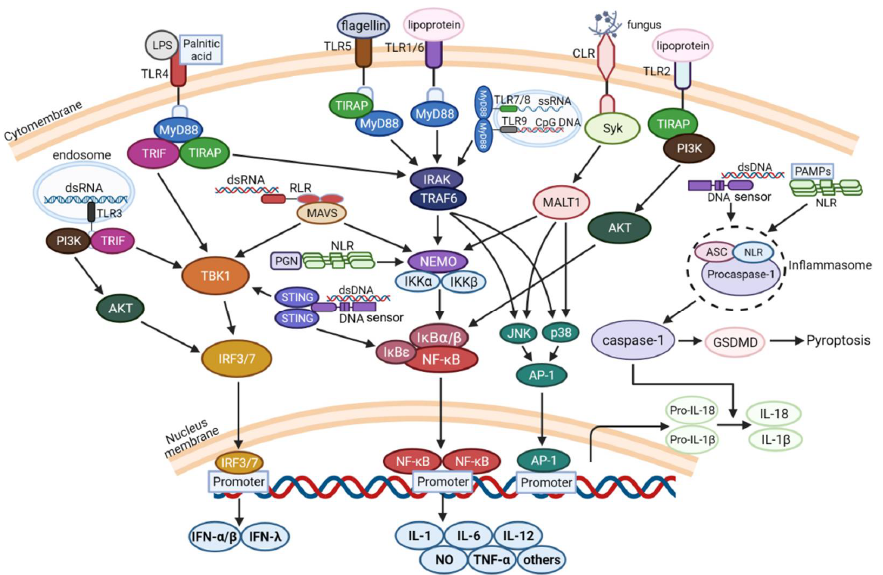
Figure 2. Schematic diagram of signaling transduction pathways in host response induced by recog- nition of PAMPs by PRRs. Sensing PAMPs, the PRRs recruit and activate MyD88, TRIF, TIRAP, and other adapters. These adapters transduce activating signals, which finally induce activation of transcriptional regulators NF- κ B and IRFs, leading to the expression of IFNs and proinflam- matory cytokines or mediators, such as IL-1, IL-6, IL-12, TNF- α , NO, etc. Abbreviation: MyD88, myeloid differentiation factor 88; TRIF, TIR domain-containing adapter-inducing IFN- β ; TIRAP, TIR domain-containing adapter protein; IRAK, IL-1 receptor kinase; TRAF, tumor necrosis factor receptor- associated factor; MALT1, mucosa-associated lymphoid tissue lymphoma translocation gene 1; Syk, spleen tyrosine kinase; TAK, TGF- β activated kinase; NEMO, NF- κ B essential modulator; IKK, in- hibitor of NF- κ B kinase; I κ B, inhibitor of NF- κ B; MAVS, mitochondrial antiviral signaling protein; PI3K, phosphoinositol-3 kinase; NF- κ B, nuclear factor kappa enhancer binding protein; IRF, interferon regulatory factor; RIG-I, retinoic acid-inducible gene I; MDA5, melanoma differentiation-as- sociated gene 5; STING, stimulator of interferon genes; LPS, Lipopolysaccharide; GSDMD, gasder- min D.